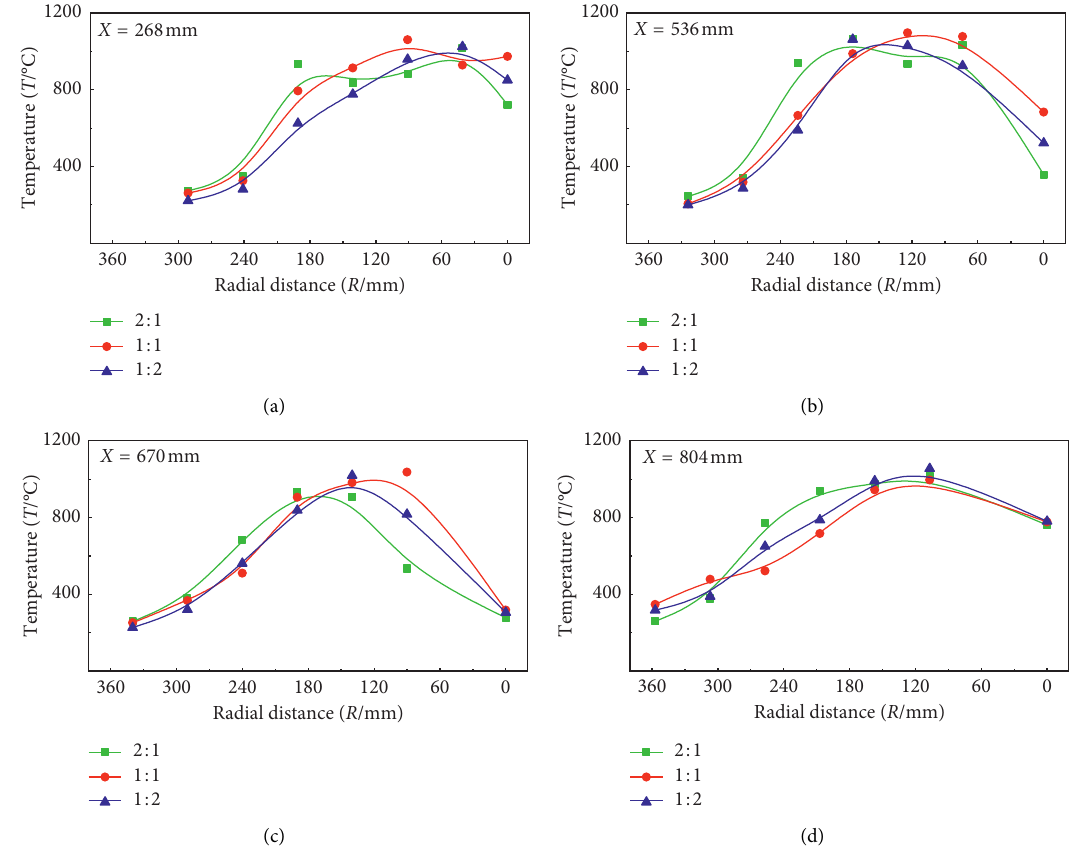
Figure 3: Temperature profiles along radial distance for different ISA/OSA. (a) X � 268 mm. (b) X � 536mm. (c) X � 670mm. (d) X �